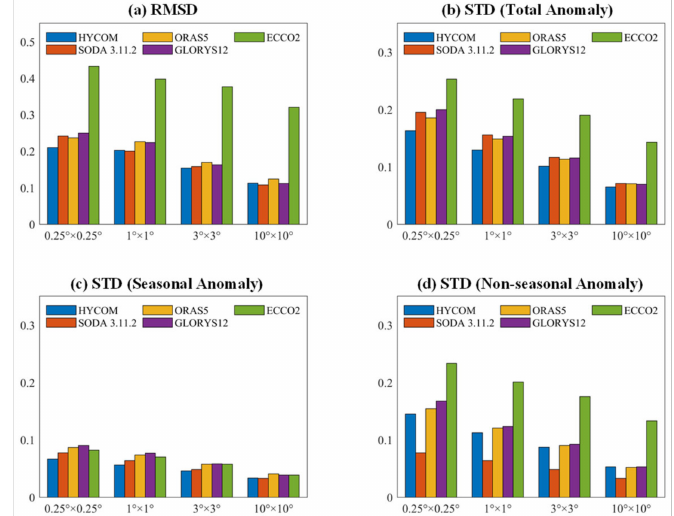
Figure 9. ( a ) Global average of temporal RMSD values between each reanalysis product and CMEMS L4 SSS product on four spatial scales indicated by legends along the horizontal axis. Global average of temporal STD values for the differences between each reanalysis product and CMEMS L4 SSS product on four different spatial scales for ( b ) total anomaly, ( c ) seasonal anomaly and ( d ) non-seasonal anomaly. The RMSD and STD values are in the unit of